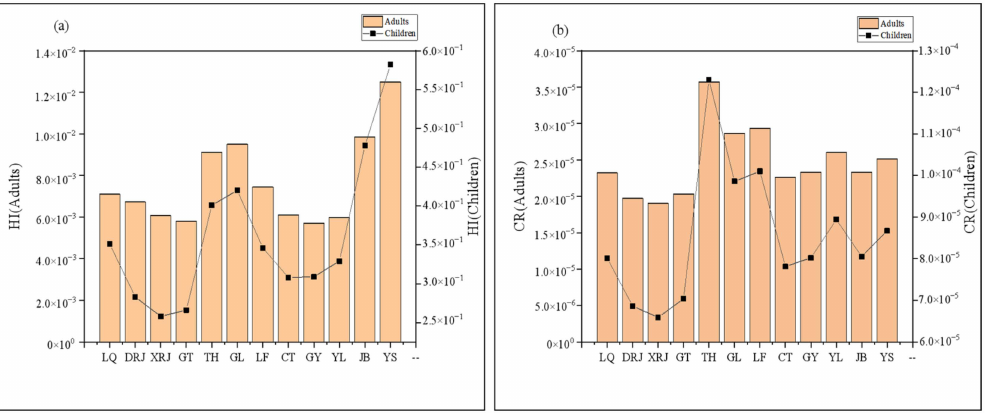
Figure 9. Spatial distribution of heavy metal(loid)s HI ( a ) and CR ( b ) in surface